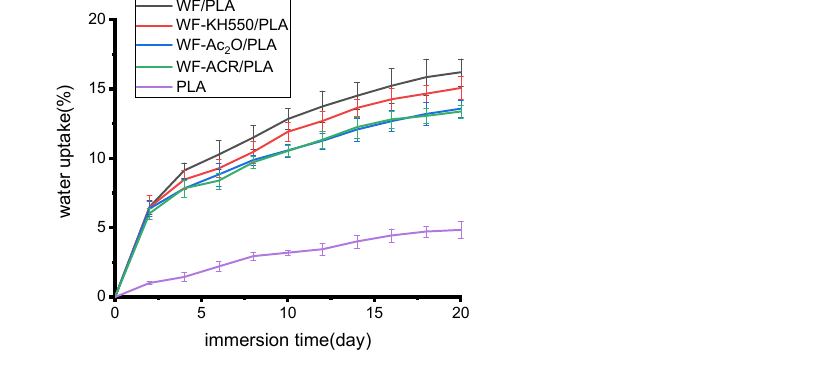
Figure 6. Effect of WF pretreatment and compatibilizer on water absorption of 3D-printed specimens with time.